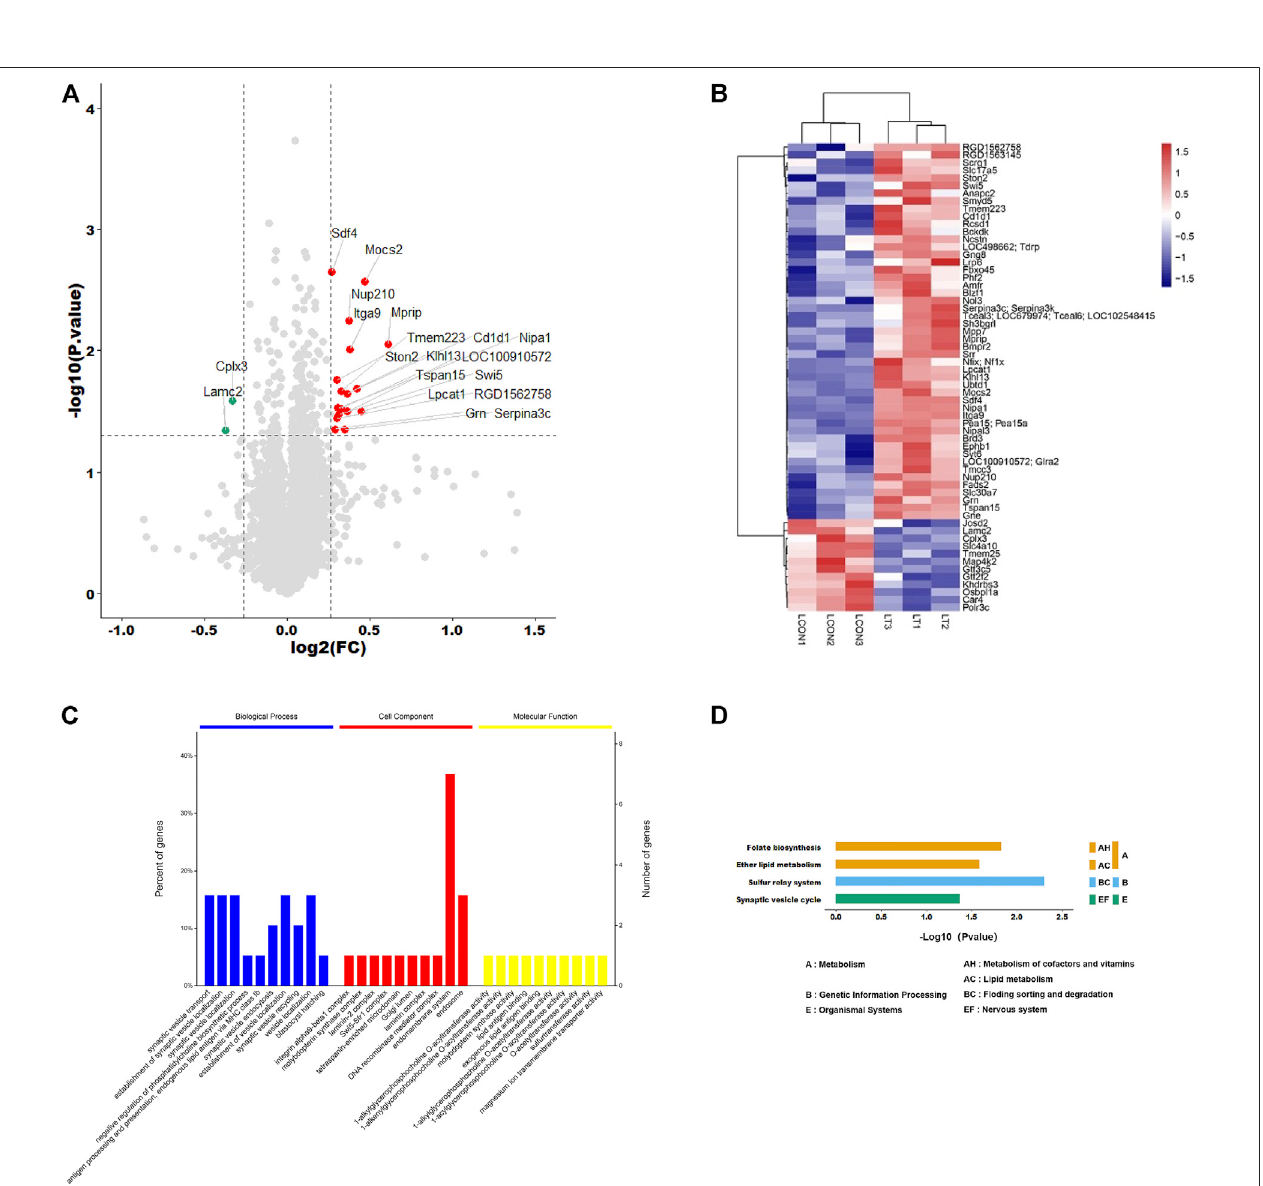
FIGURE 1 | Identi fi cation and analysis of differentially expressed proteins. (A) Volcano plots presenting the proteins differences between the two groups, and proteinsthathaveasigni fi cantlyhigherlevelintheexperimentalgrouparedottedinred,andthosethathavealowerlevelaredottedingreen(Foldchange > 1.2,adjusted p -value < 0.05). (B) Heat map shows theprotein clustering results in twogroups (red representsupregulated proteins and blue representsdownregulated proteins). (C) Signi fi cance enrichment analysis of GO annotation in biological process, cell component, and molecular function. (D) Based on the KEGG database, the main pathways involved were ether lipid metabolism, folate biosynthesis, sulfur relay system, and synaptic vesicle cycle in the network.